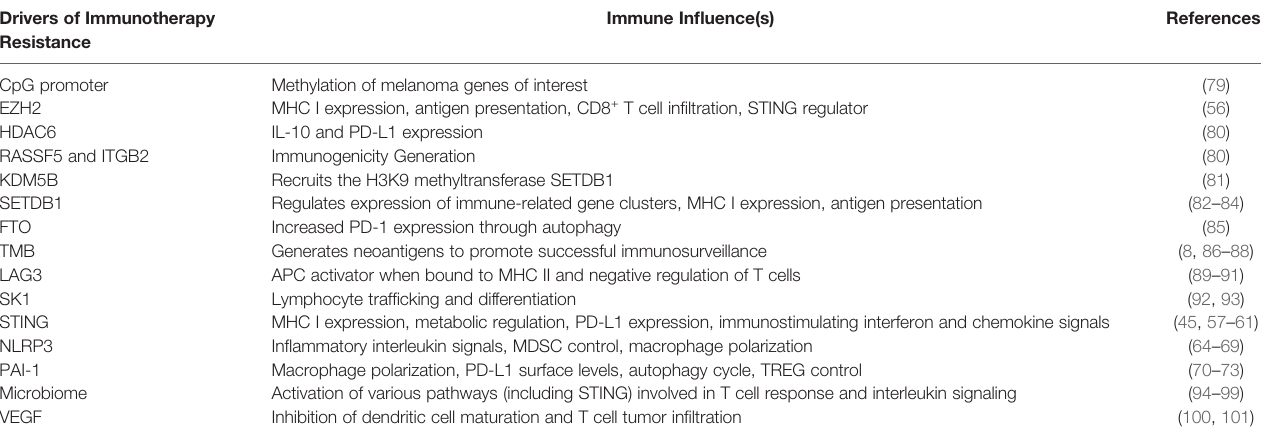
TABLE 1 | Recently revealed drivers of immunotherapy resistance and their in fl